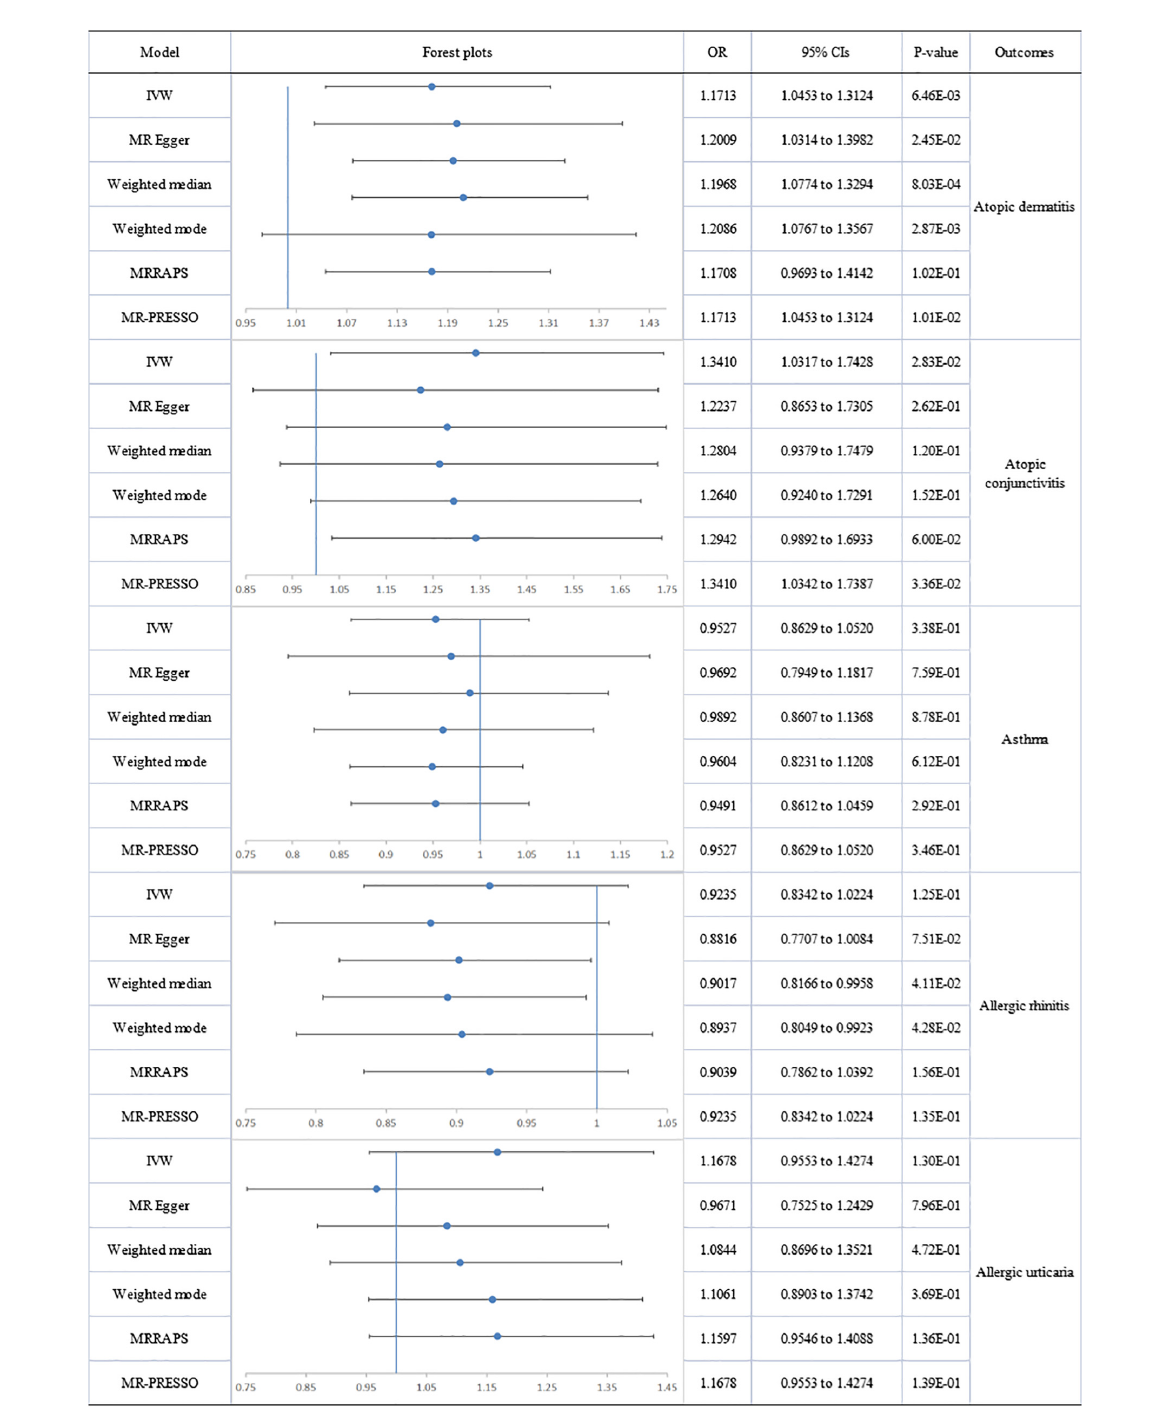
reported by observational studies cannot be equated with direct causal correlation. MR avoids the influence of confounding factors through genetic instrumental variables and accurate